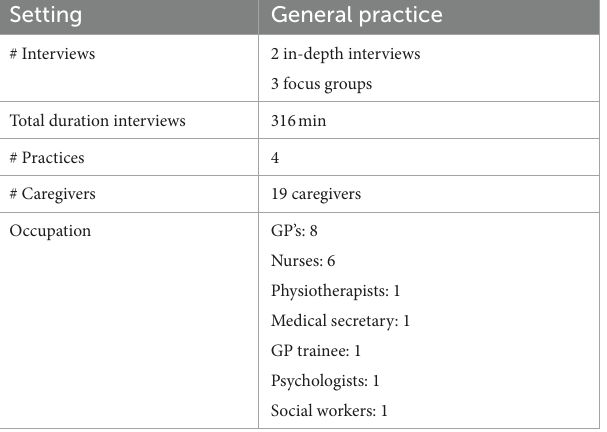
TABLE 4 Overview of research characteristics in stage 2.